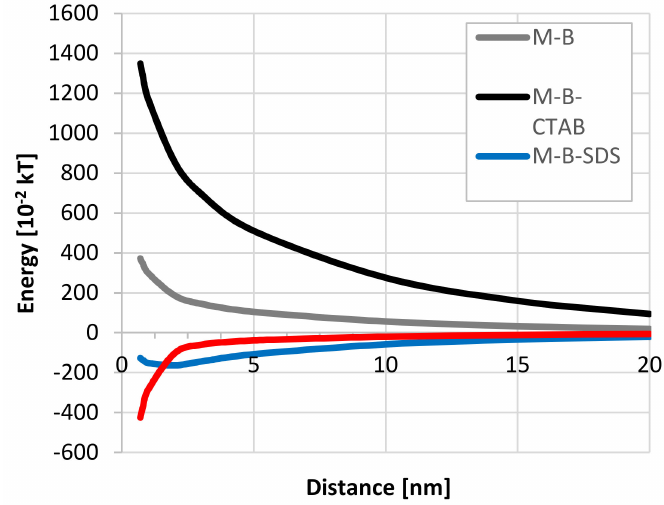
Figure 6. Mineral-bacteria-surfactant energy diagrams at pH 3, ionic strength 10 − 3